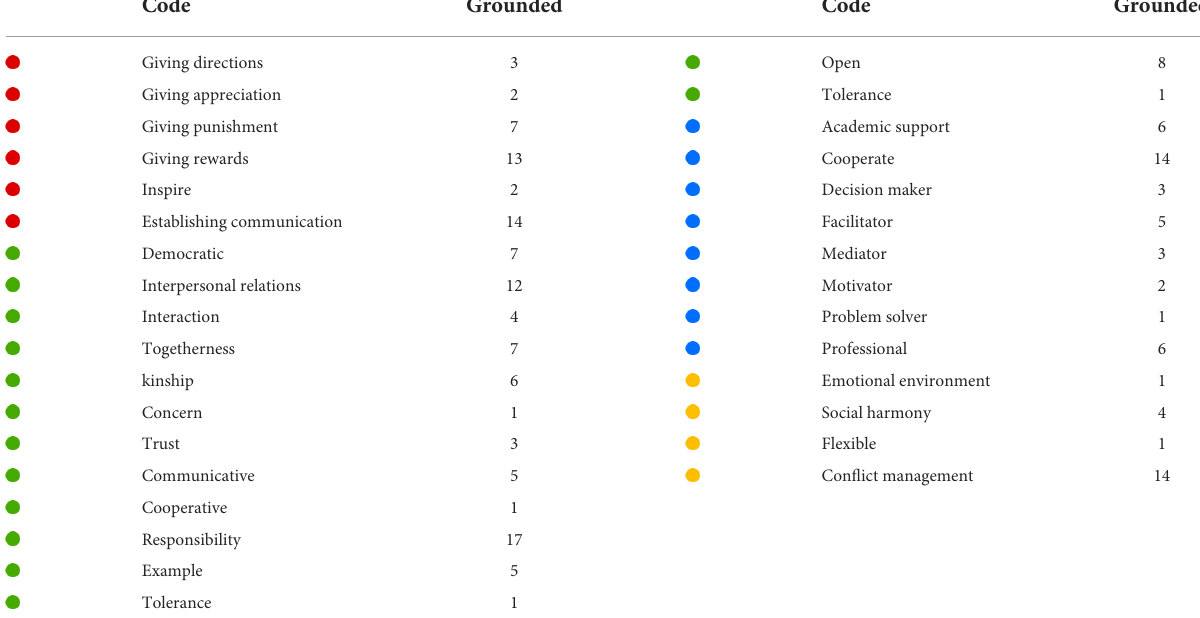
TABLE 1 Codes for the principal’s role in managing